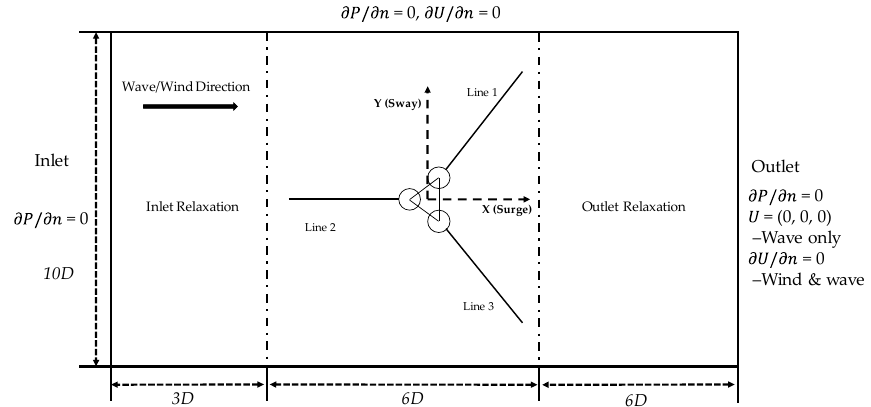
Figure 4. Sketch of the computational domain in XOY plane used in the present study.